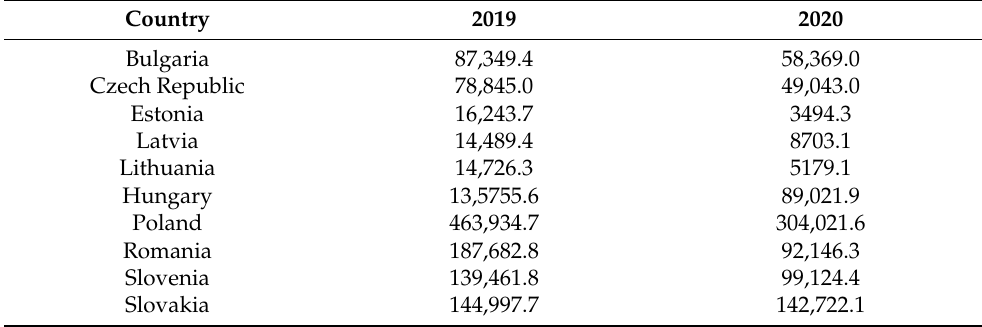
Table 4. Greenhouse gas emission levels in 2019 and 2020 in Central and Eastern European countries.